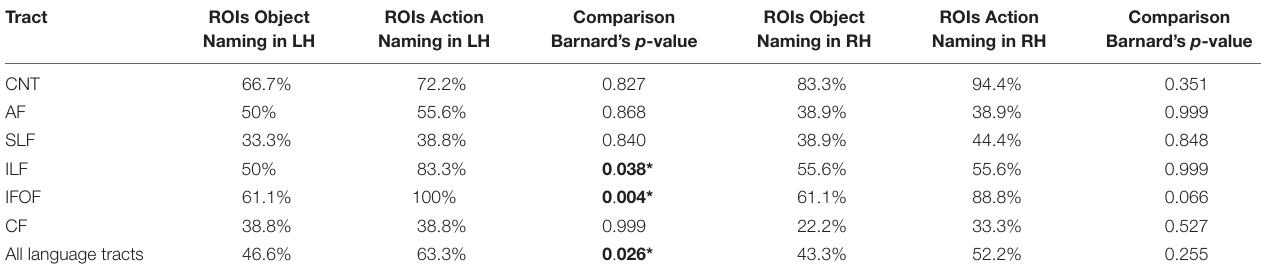
TABLE 2 | Percentages of participants with visualized tracts (with Barnard’s test comparison between task ROIs in the LH and RH). Tract